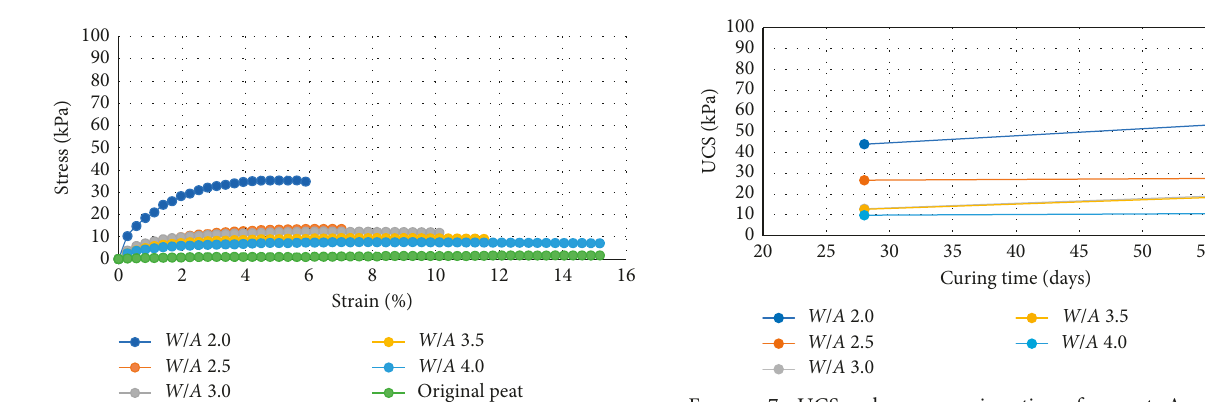
Figure 4: Stress vs. strain of peat B specimens after 56 days air- cured.